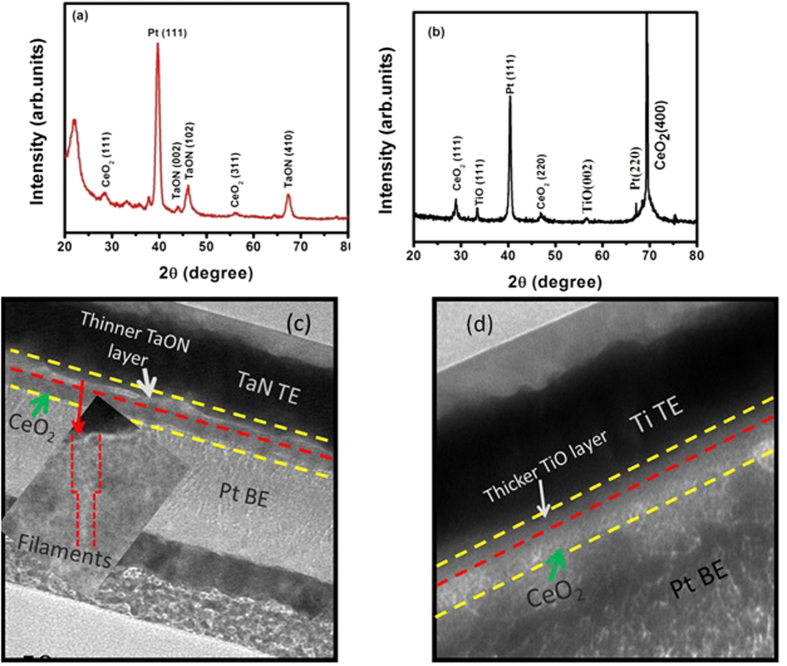
X-ray diffraction patterns for the (a) TaN/CeO2/Ti/CeO2/Pt, (b) TaN/CeO2/Ti/CeO2/Pt stacks and Cross-sectional HRTEM images of (c) TaN/CeO2/Ti/CeO2/Pt, (d) Ti/CeO2/Ti/CeO2/Pt stacks.